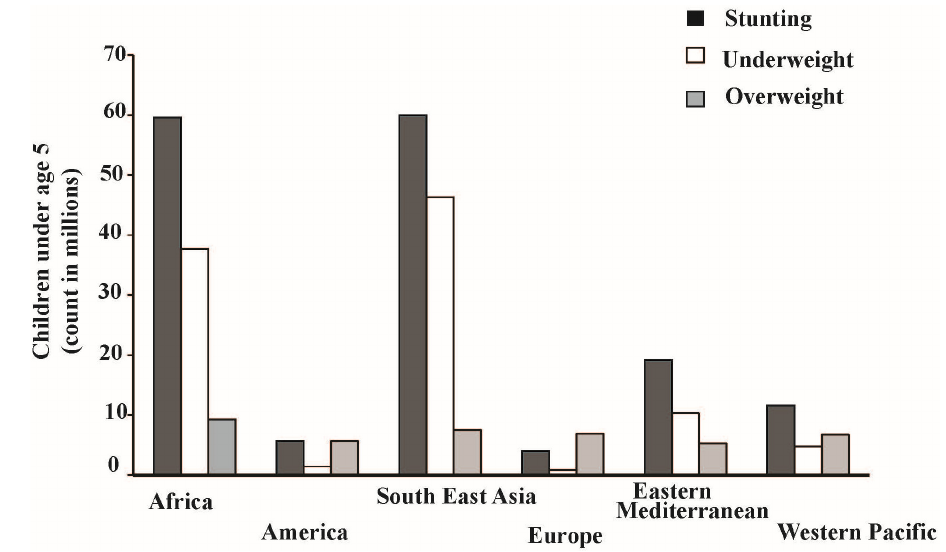
Figure 1. Prevalence of stunting, underweight, and overweight among children under age of 5 (Data adopted from [14]; WHO, 2015)